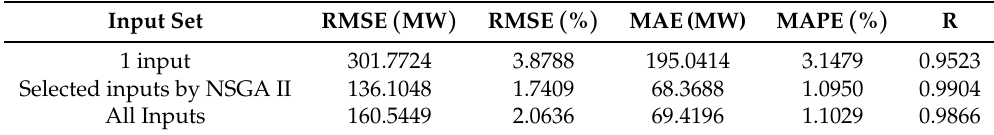
Table 1. Forecasting results for different input sets using MLPNN.